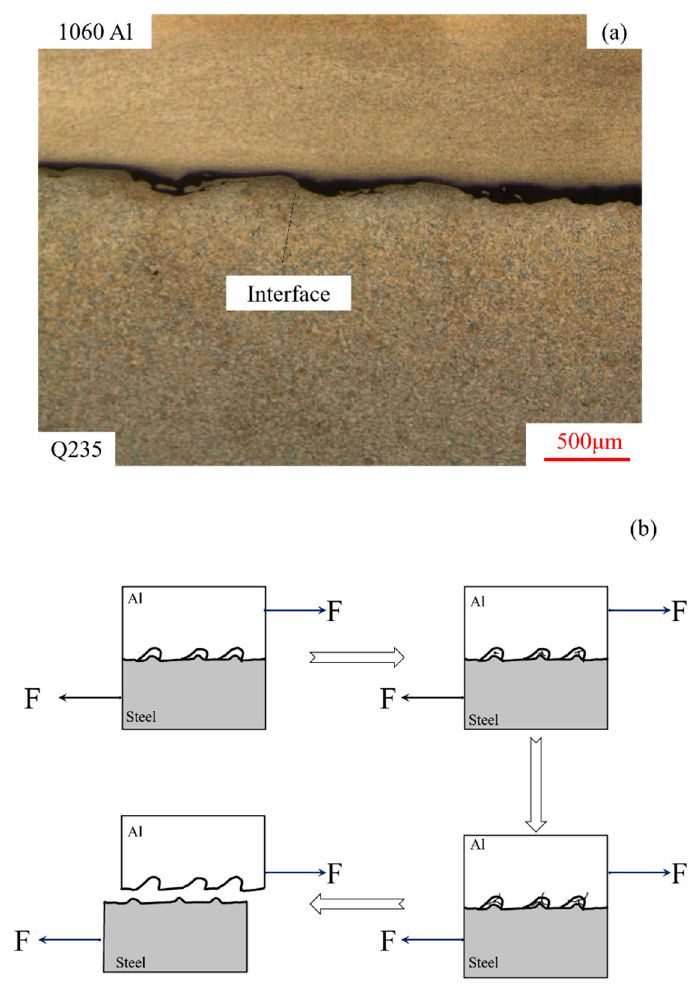
Figure 15. Failure mechanism of thick and discontinuous interface. ( a ) physical diagram; ( b ) failure diagram of flat interface.